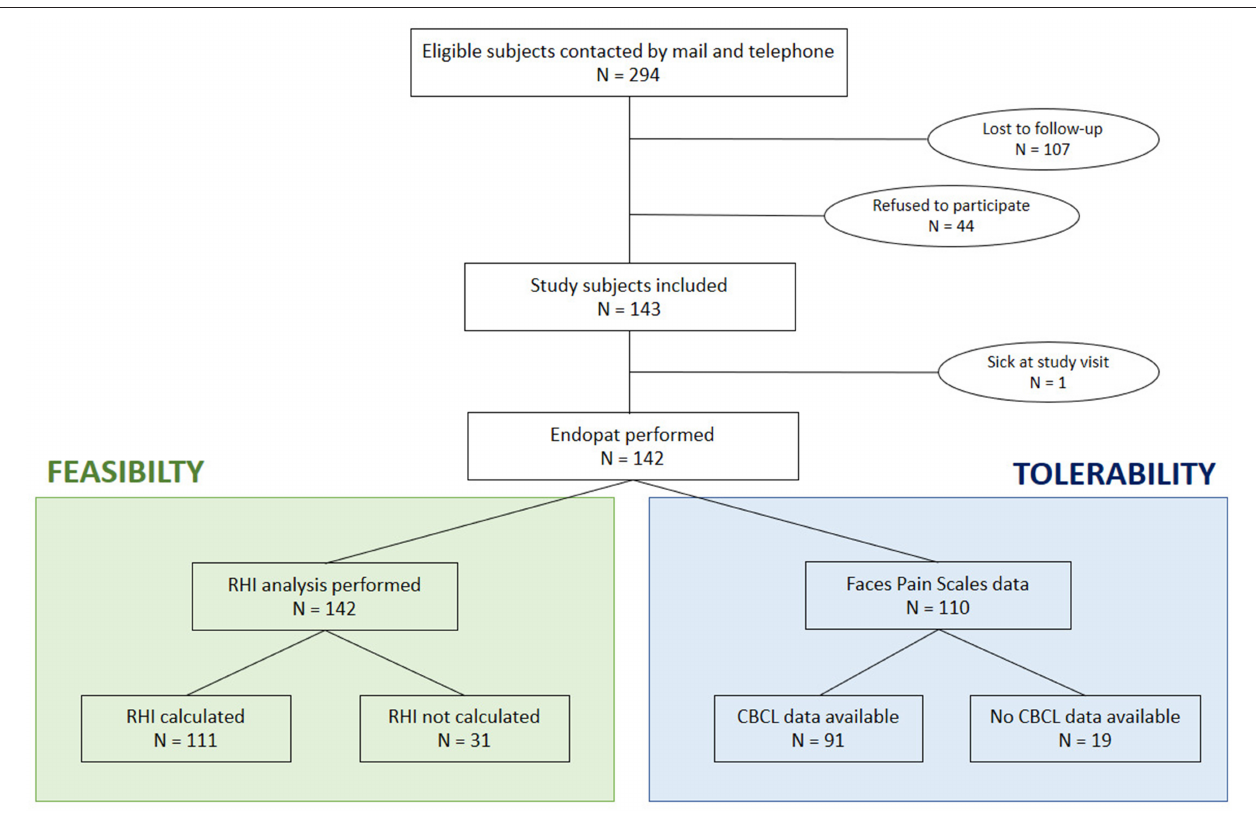
FIGURE 1 | Flow chart of patient inclusion. RHI, reactive hyperemia index; CBCL, child behavior checklist.